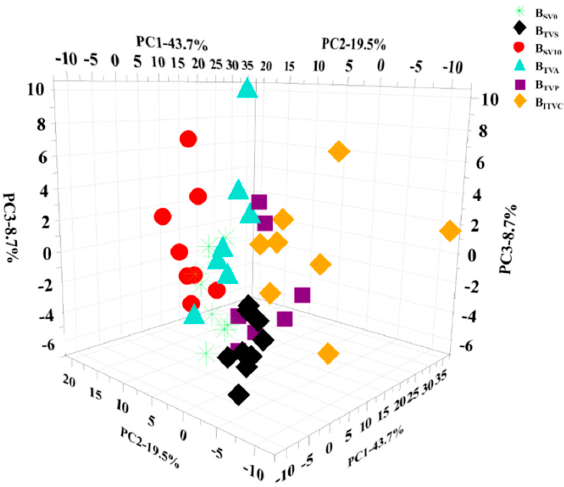
Figure 5. Loading plots of principal component analysis (PCA) of the NMR spectral data for all serum samples. Note: Every sample is represented by a unique pattern .